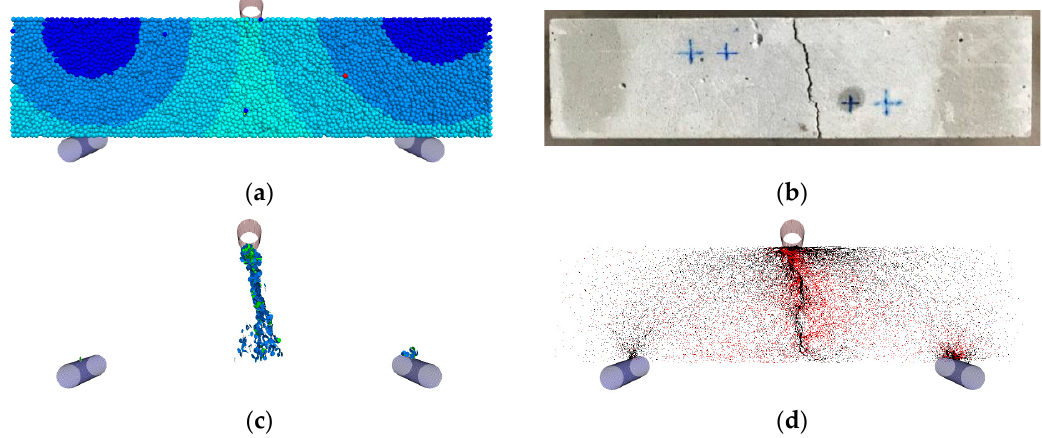
Figure 31. The flexural failure mode of the foamed concrete with a density of 600 kg/m 3 at a loading rate of 0.6 mm/min. ( a ) The failure of the numerical model; ( b ) the failure of the specimen; ( c ) crack development inside foam concrete; ( d ) force-chain distribution.